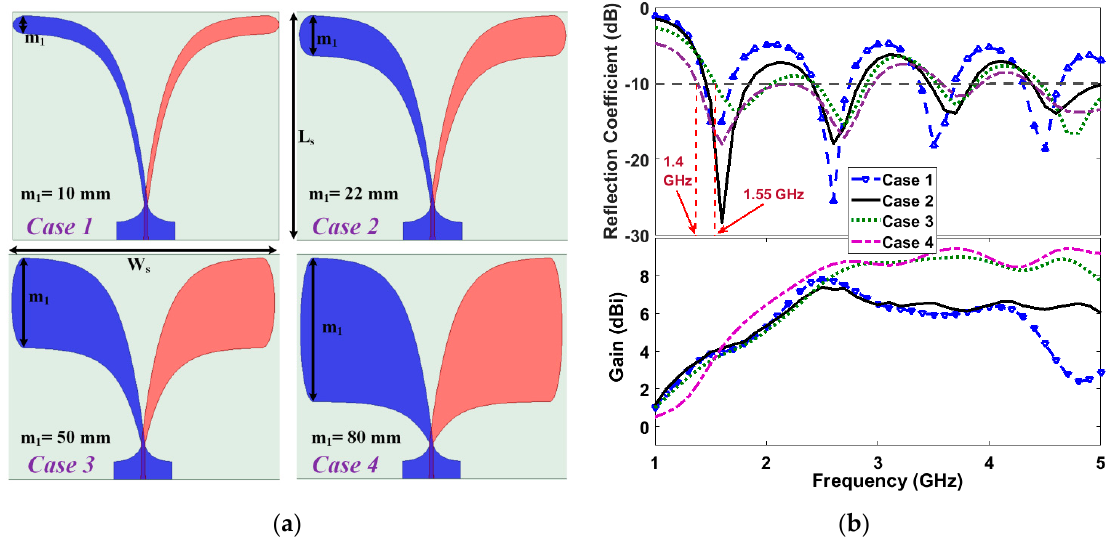
Figure 1. Antipodal Vivaldi antenna configuration with ( a ) different widths of tapered strips, and ( b ) their reflection coefficient and gain.